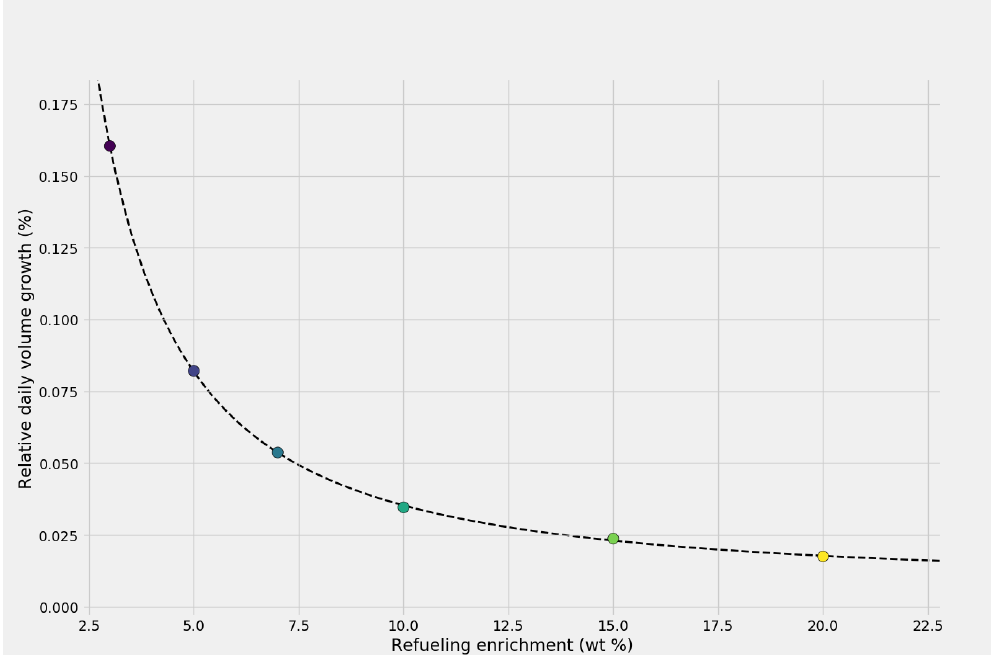
Figure 7. The relative percent daily growth in fuel salt volume for different enrichments of the refuel salt, given a 20MW/MTU power density. The dashed curve is to guide the